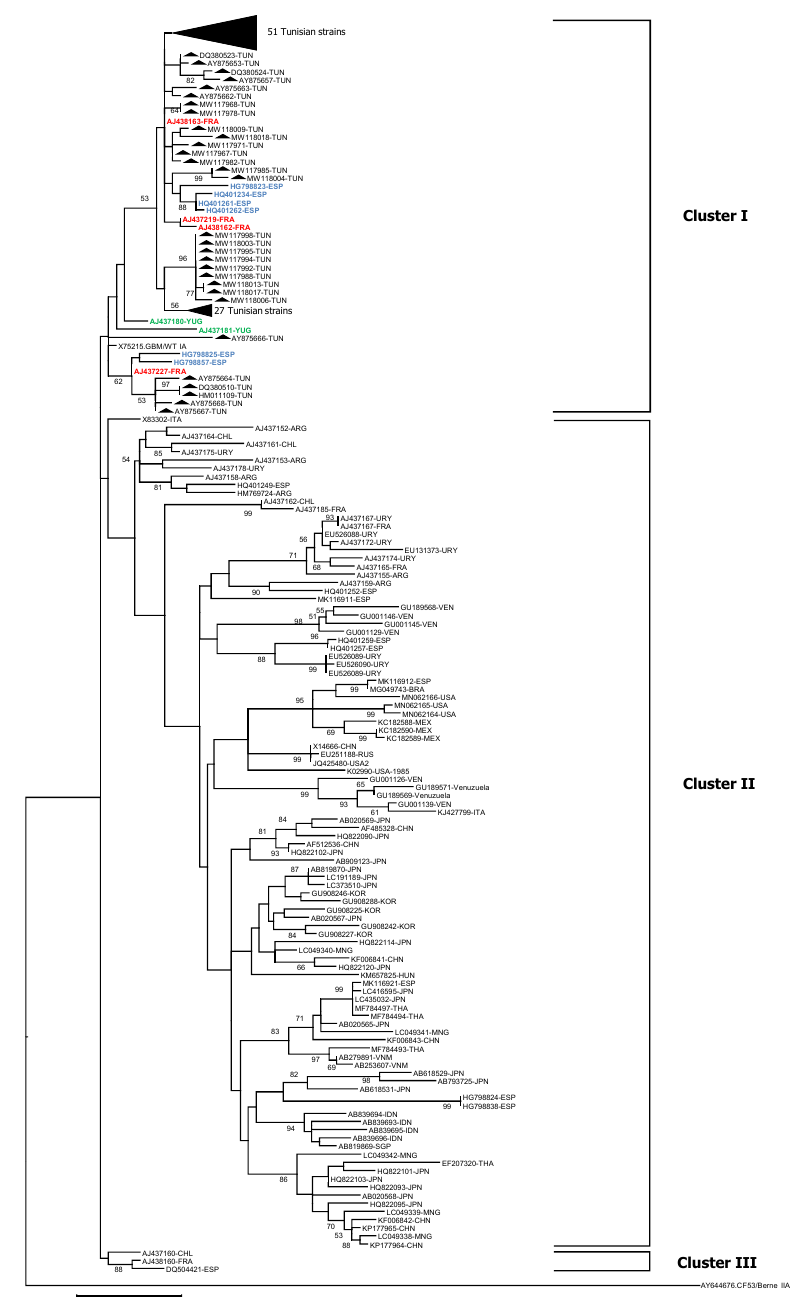
Figure 3. Phylogenetic tree based on the analysis of the whole VP1 region belonging to genotype IA, constructed using the maximum likelihood method and the kimura-2 parameter model. The tree includes HAV Tunisian 45 sequences reported in this study and 57 previously published sequences from Tunisia and 118 from other countries. Sequences from 21 different countries (Italy, France, Argentina, Chile, Uruguay, Spain, Venezuela, Brazil, USA, Mexico, China, Russia, Japan, South Korea, Mongolia, Hungary, Thailand, Vietnam, Indonesia, Singapore and Yugoslavia) were retrieved from GenBank. The sequences of isolates are indicated by their accession number and the country code. Black triangles represent Tunisian isolates. Sequences from others countries grouped with the Tunisian isolates are represented in different colors (sequences from France in red, from Spain in blue and from Yugoslavia in green). Topology was supported by 1000 bootstrap replicates. Bootstrap values lower than 50 were not indicated. Reference strain CF53 was used as an